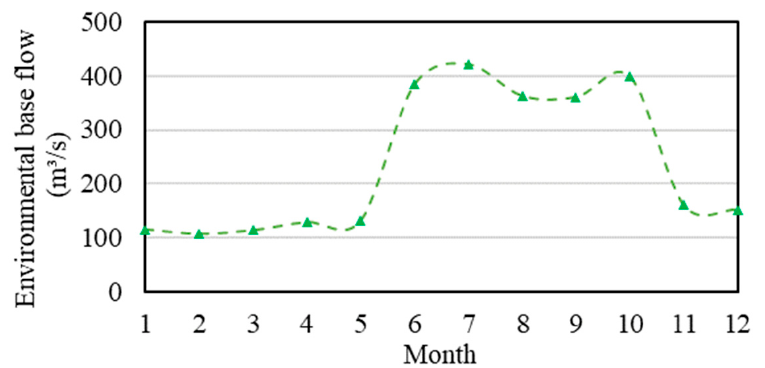
Figure 11. Monthly environmental base flow.